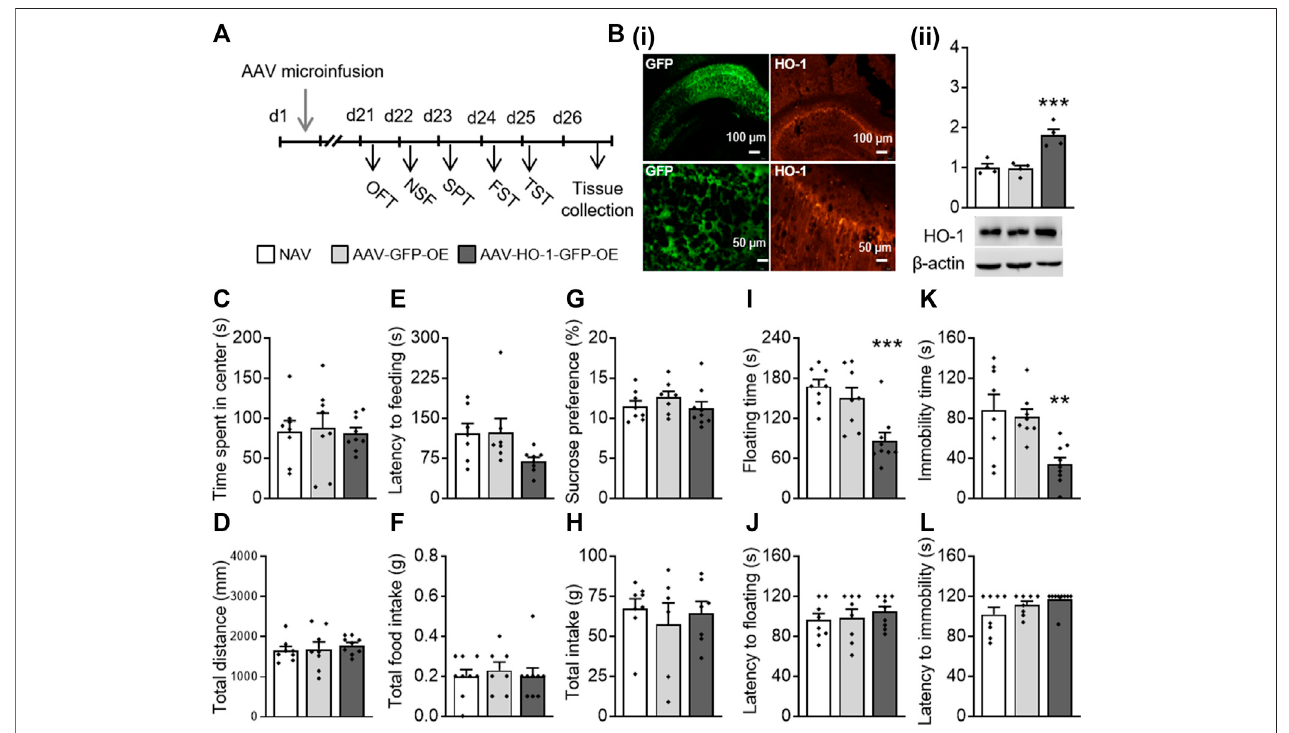
FIGURE 1 | Dorsal hippocampal HO-1 overexpression produced antidepressant-like effects. (A) AAV-HO-1 virus was infused bilaterally into the dorsal hippocampusofmicebeforebehavioraltesting. (B) HO-1proteinlevelsweresigni fi cantlyincreasedinthedorsalhippocampusarea,asimitatedbyimmuno fl uorescence staining (i) andWesternblot (ii) .Timespentinthecentralzone (C) andtotaldistance (D) weresimilaracrossallgroupsintheOFT.HO-1overexpressionhasnoeffecton latency to feeding (E) and total food intake (F) in the NSF test. Nochange occurred in sucrose preference (G) and total intake (H) after administration ofAAV-HO-1 intheSPT.HO-1overexpressionsigni fi cantlydecreasedthe fl oatingtime (I) intheFSTandimmobilitytime (K) butnot fl oatinglatency (J) andimmobilitylatencyintheTST (L) . Dorsal hippocampal AAV-GFP infusion had no effects on these behaviors. The data are expressed as mean ± SEM and were analyzed with separate one-way ANOVAs. ** p < 0.01, *** p < 0.001 versus naive group. NAV, naive; AAV, adeno-associated virus; HO-1, heme oxygenase-1; OFT, open fi eld test; NSF, novelty- suppressed feeding; SPT, sucrose preference test; FST, forced swimming test; TST, tail suspension test ( n (cid:2) 4 per group for WB analysis, n (cid:2) 7 – 9 per group for behavioral